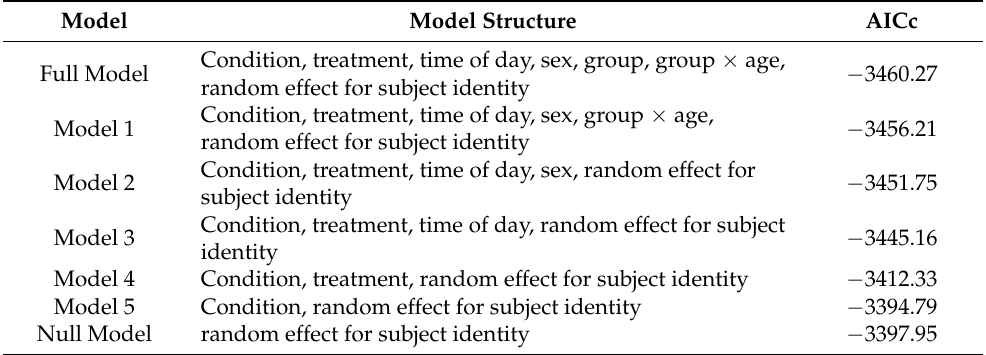
Table 7. Model structures and AIC values obtained during model selection for agonistic